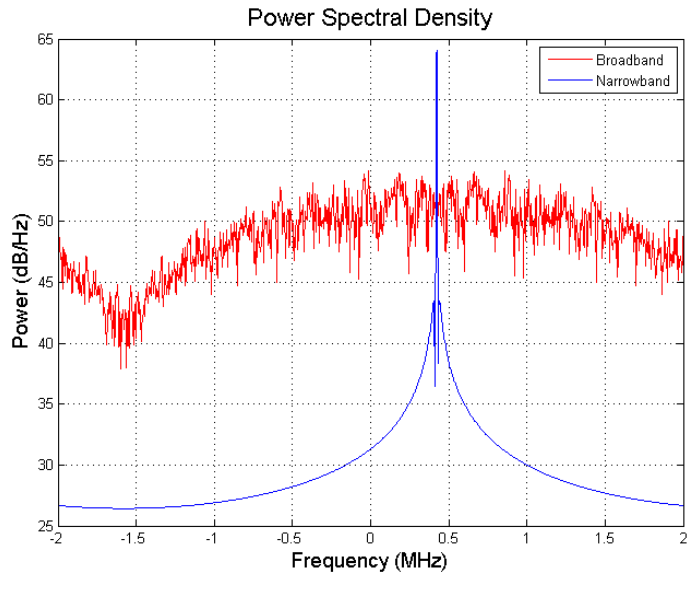
Figure 12. Power spectral density of broadband and narrowband interferers.